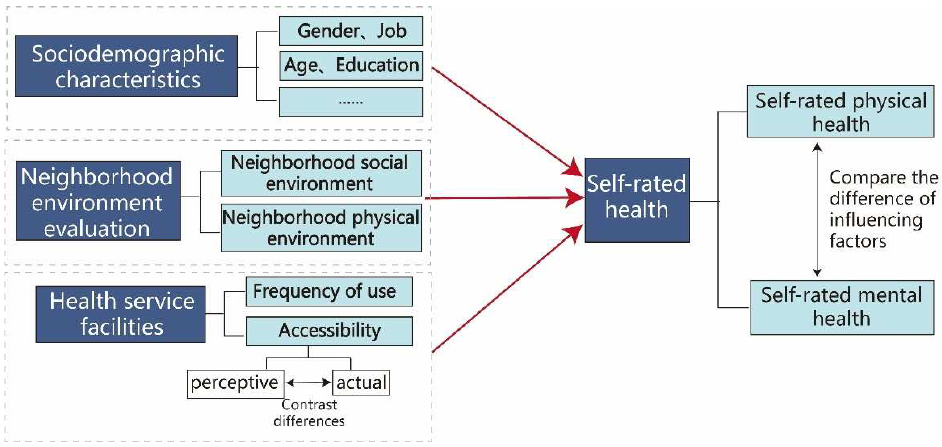
Figure 1. Research framework.